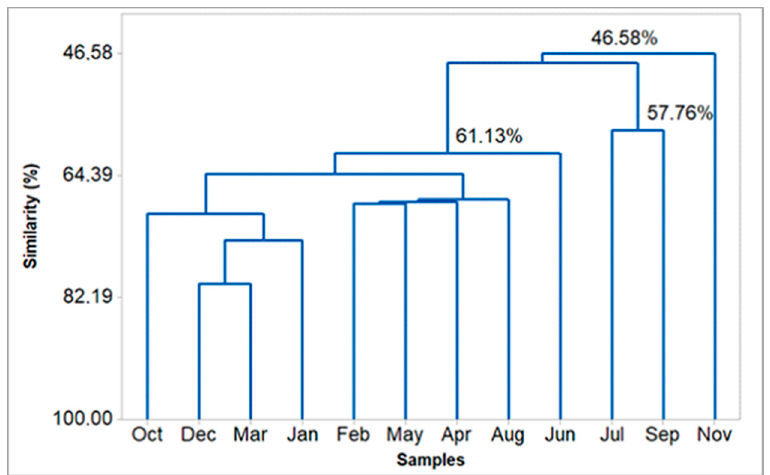
Figure 5. Hierarchical clustering analysis (HCA) of the Eugenia uniflora oils, based on their main constituents.